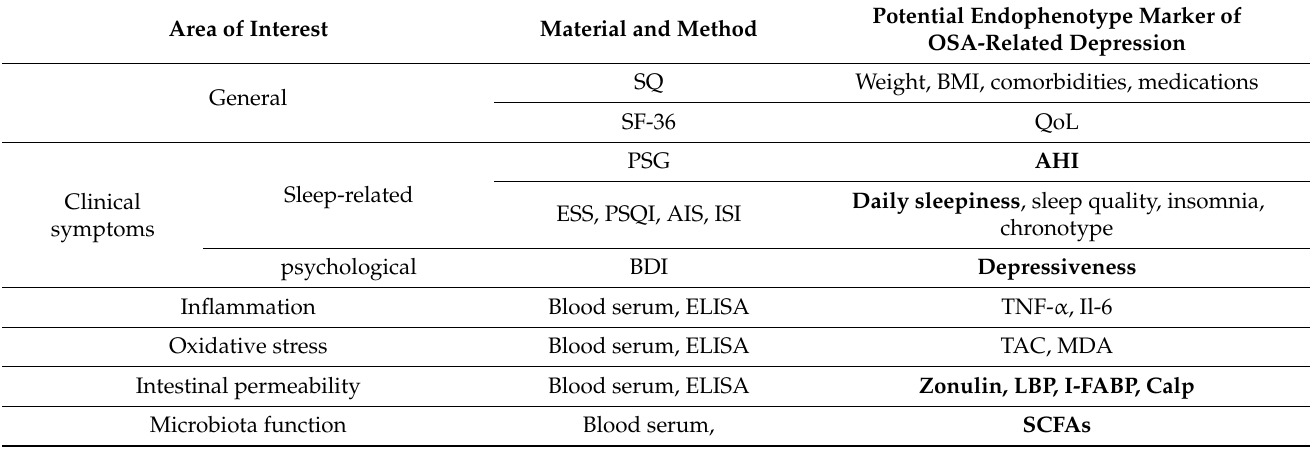
Table 1. Primary ( in bold ) and secondary outcome